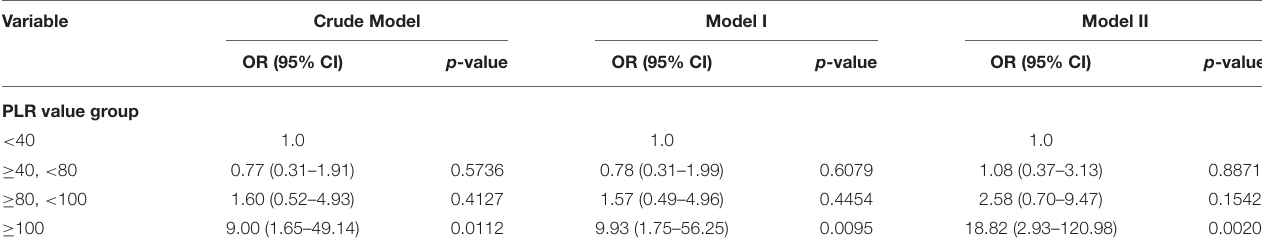
Crude model adjusted for: None. Model I adjusted for gestational age, birth weight, sex, and VD. Model II adjusted for gestational age, birth weight, sex, VD, CA, PE, GDM, and CRP. PLR, platelet-to-lymphocyte ratio; NEC, necrotizing enterocolitis; OR, odds ratio; CI, confidence interval; VD, vaginal delivery; CA, chorioamnionitis; PE, preeclampsia; GDM, gestational diabetes mellitus; CRP, C-reactive